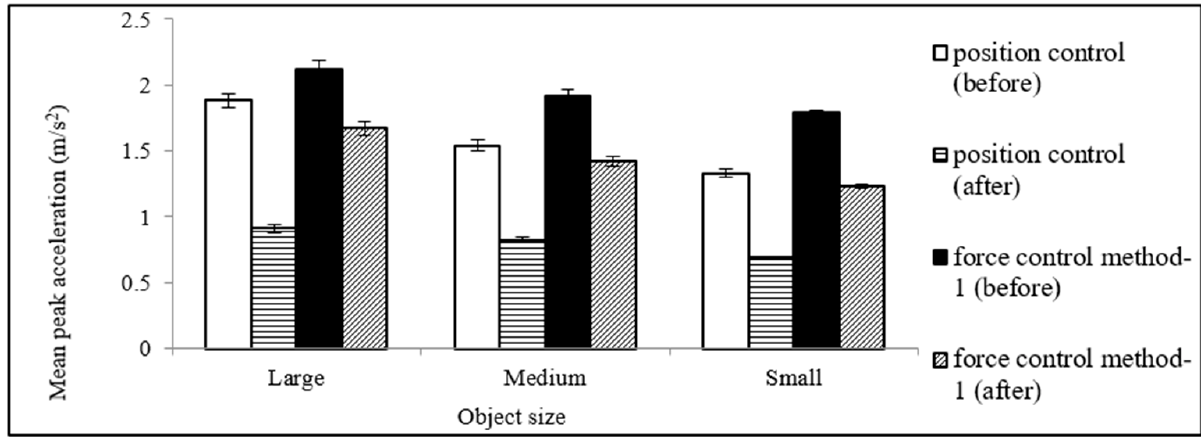
Figure 10. Mean (here, n = 20) peak accelerations for the position control and force control method 1 for different sizes of lifted objects before (experiment 1) and after (experiment 2) the implementation of the novel adaptive control algorithm.